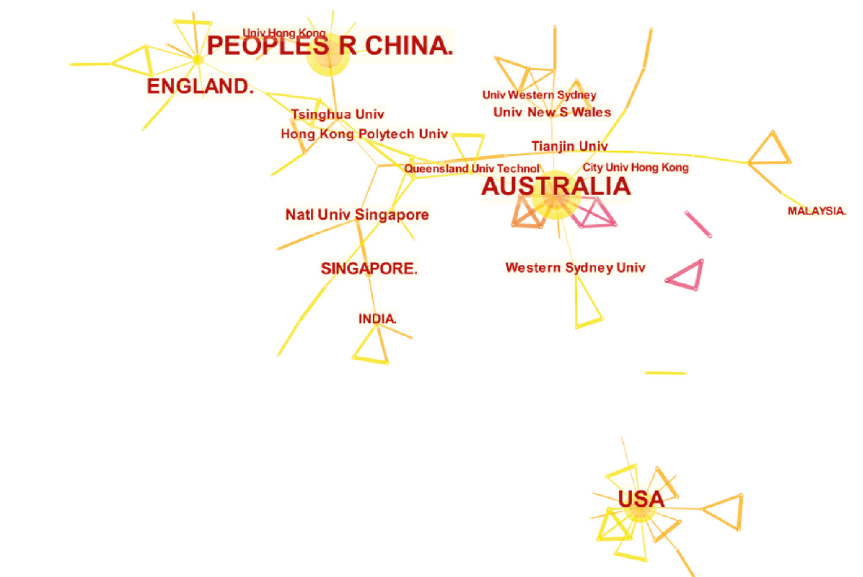
Figure 3: Color interpretation.